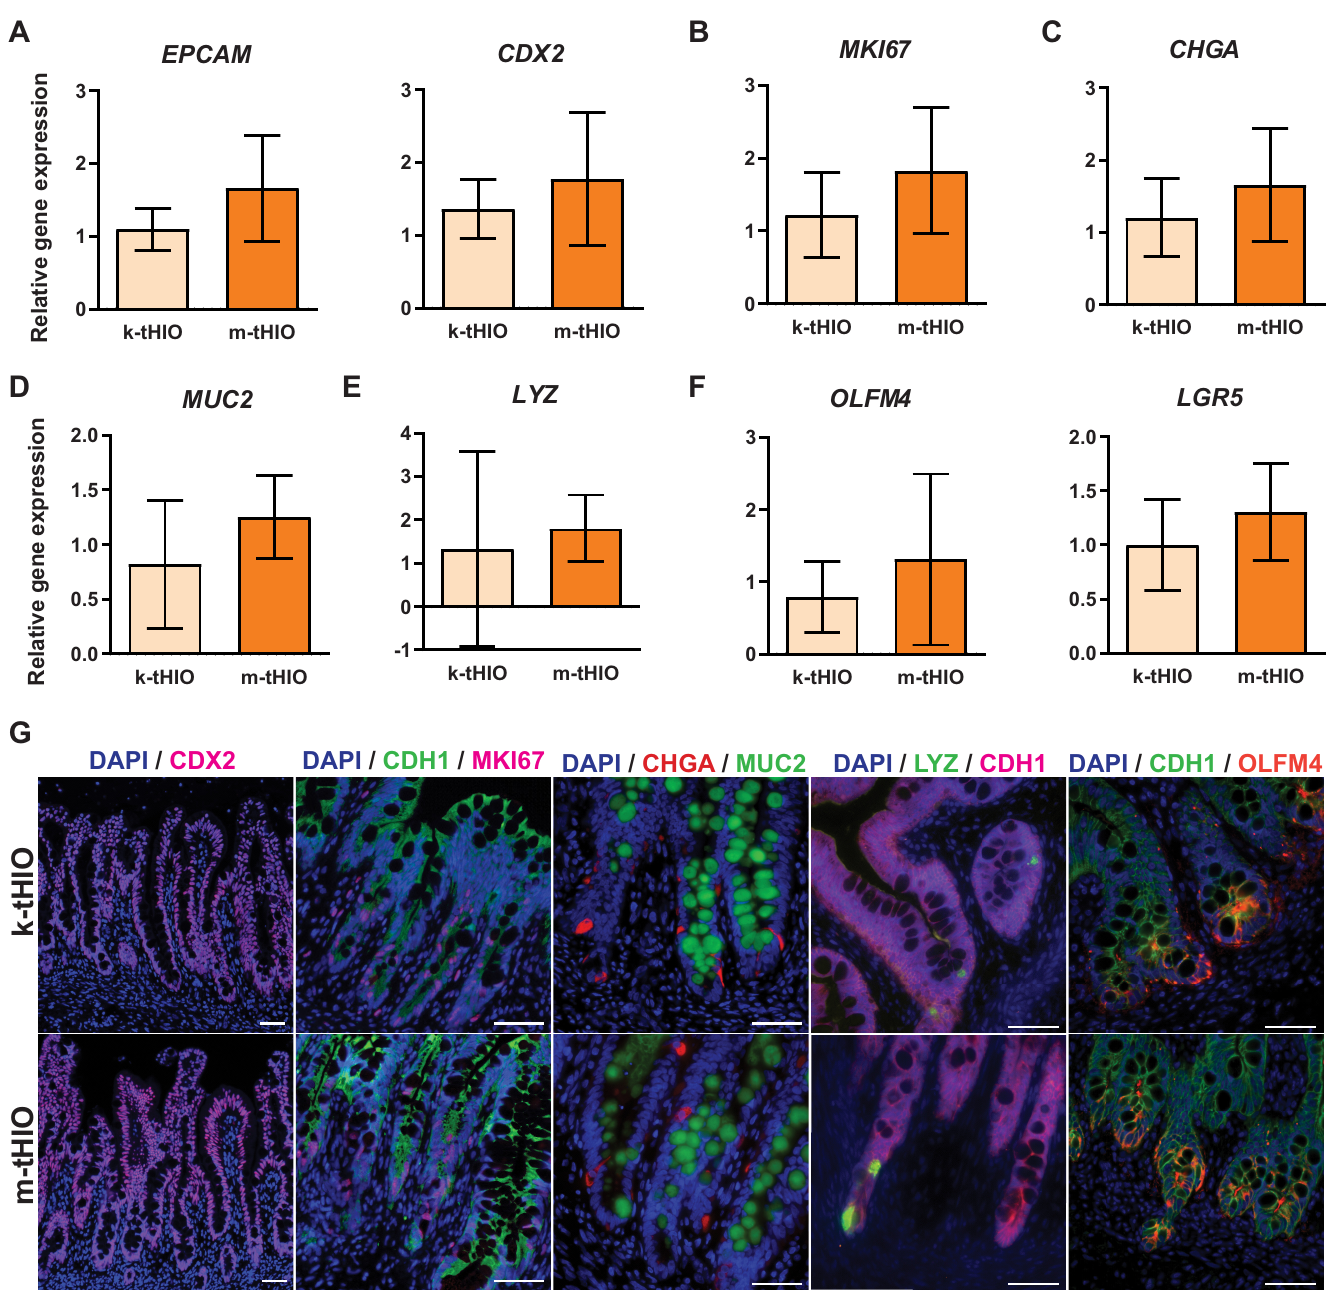
Fig 3. Grafts harvested from both sites developed secretory epithelial lineages. (A) Relative gene expression in k-tHIO and m-tHIO for epithelial development by EPCAM and CDX2. (B) Relative gene expression in k-tHIO and m-tHIO for proliferation by MKI67. (C) Relative gene expression in k-tHIO and m-tHIO for EECs by CHGA. (D) Relative gene expression in k-tHIO and m-tHIO for goblet cells by MUC2. (E) Relative gene expression in k-tHIO and m-tHIO for Paneth cells by LYZ. (F) Relative gene expression in k-tHIO and m-tHIO for the stem compartment by OLFM4 and LGR5. (A-G) For k-tHIO, n = 7 and for m-tHIO n = 5; p = n.s. for all. (G) Protein level expression, by immunofluorescence, in k-tHIO and m-tHIO associated to transcripts observed in A-F. Scale bars = 50 μ